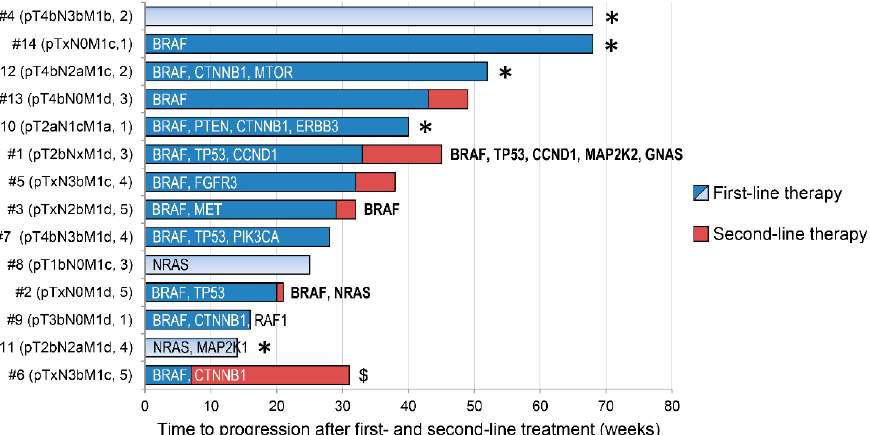
Figure 2. Summary of the mutated genes identified by targeted NGS in the context of clinical data. The patients are ordered according to the duration of the first-line therapy. Light blue and red bars denote immunotherapy, dark blue—targeted therapy. Genes with mutations detected before the second-line therapy (LB2 in three out of five patients: #1, #2, #3) are shown in bold. The numbers in parentheses behind the TNM stage represent the number of localizations with metastases. An asterisk denotes continuation of the therapy; $—this patient had discontinuation of first-line therapy due to adverse